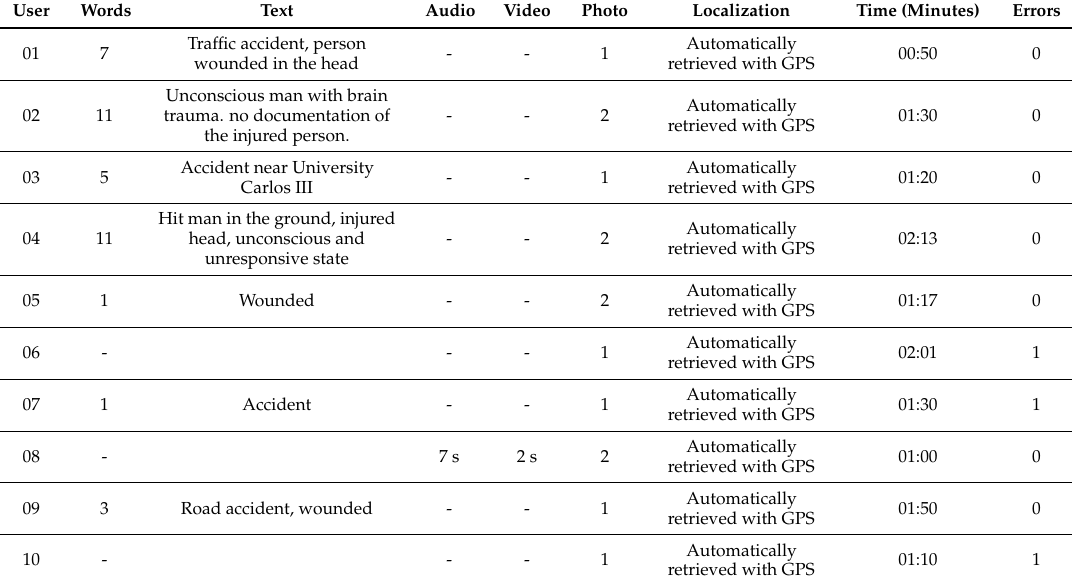
Table 3. Quantitative data resulting from the experiment.